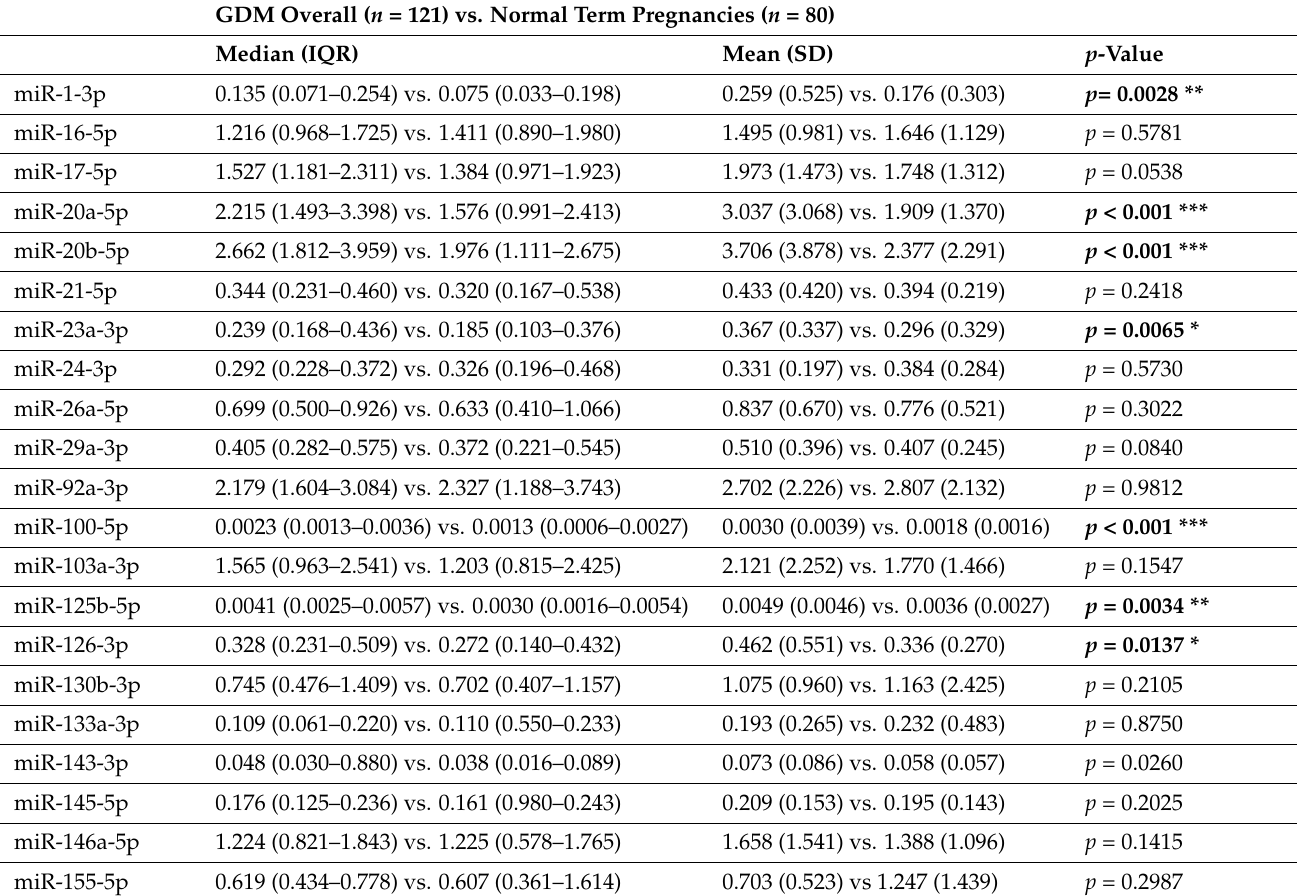
Table 3. MicroRNA expression profiles in peripheral blood leukocytes in early stages of gestation in pregnancies destinated to develop GDM and normal term